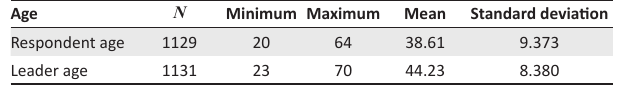
TABLE 3: Respondent and leader age (years).